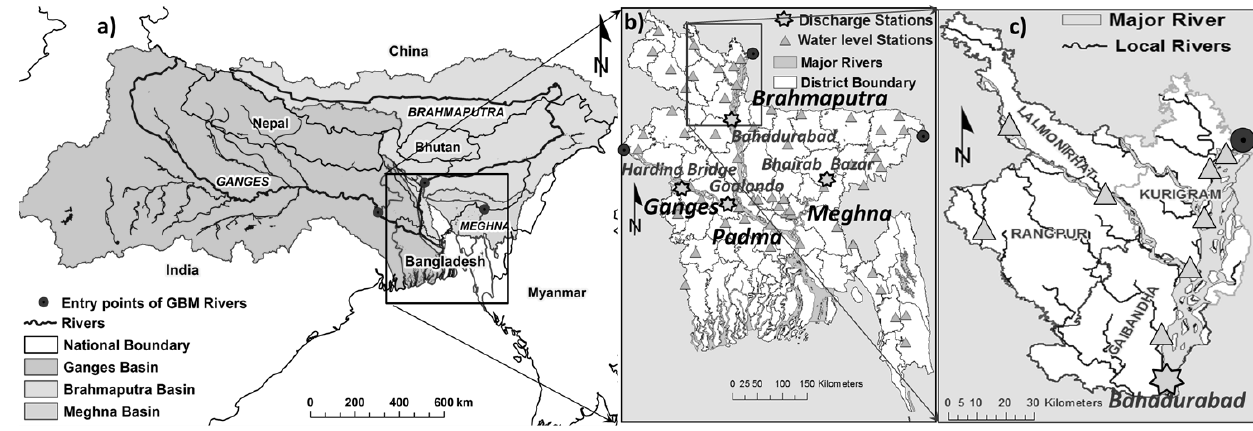
Figure 1. The Ganges, Brahmaputra and Meghna (GBM) river basin in Nepal, India, China, Bhutan and Bangladesh (a) . The Bangladesh river water level and discharge gauging stations are demonstrated in zoom-in (b) and the Lalmonirhat, Kurigram, Gaibandha and Rangpur districts in zoom-in (c)